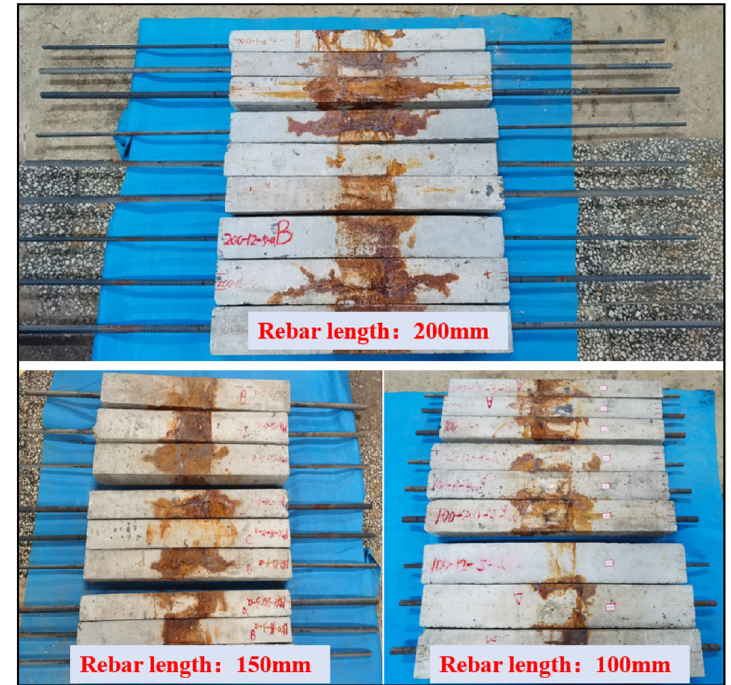
Fig. 6 Surface condition of corroded steel bar of concrete structure